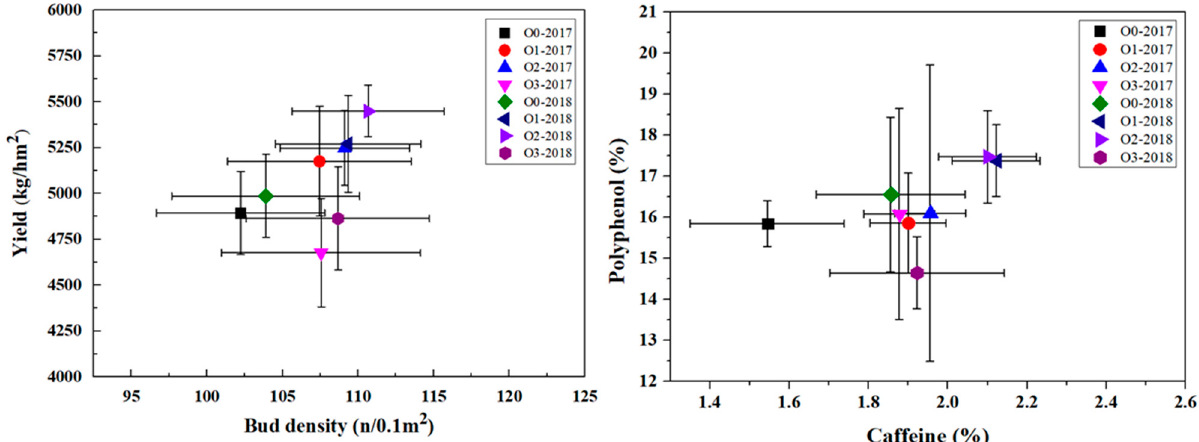
Figure 5. Variation in the tea yield, bud density, and tea polyphenol and caffeine contents in the two-year reduction experiment.